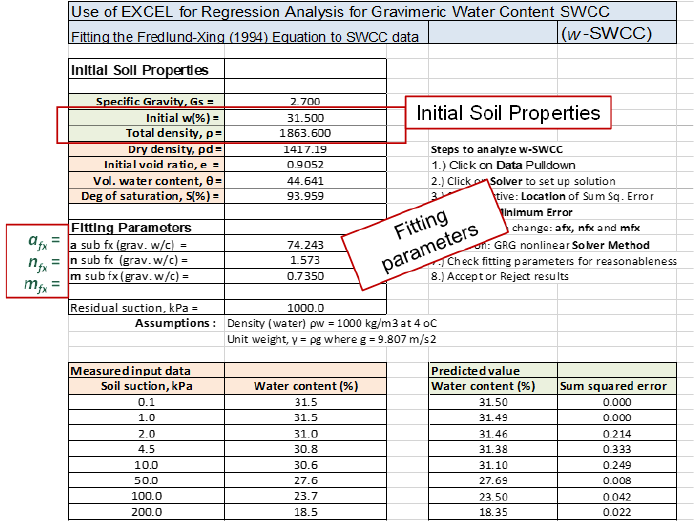
Figure 10. EXCEL spreadsheet used for a regression analysis on the w -SWCC laboratory data.